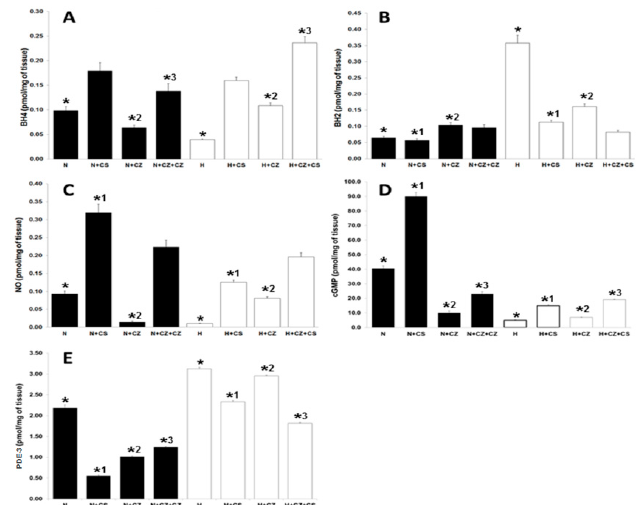
Figure 4. Evaluation of the levels of the following parameters in presence or absence of the different treatments. Tetrahydrobiopterin (BH4) (panel A ), dihydrobiopterin (BH2) (panel B ), nitric oxide (NO) (panel C ), cyclic guanosine monophosphate (cGMP) (panel D ), phosphodiesterase-3 (PDE-3) (panel E ), in ventricular tissue obtained from normotensive (black bars) and hypertensive (white bars) rats. Values represent the mean standard deviation of n = 6, (*, * 1 , * 2 , * 3 ) p ≤ 0.05, by Newman’s post hoc test.